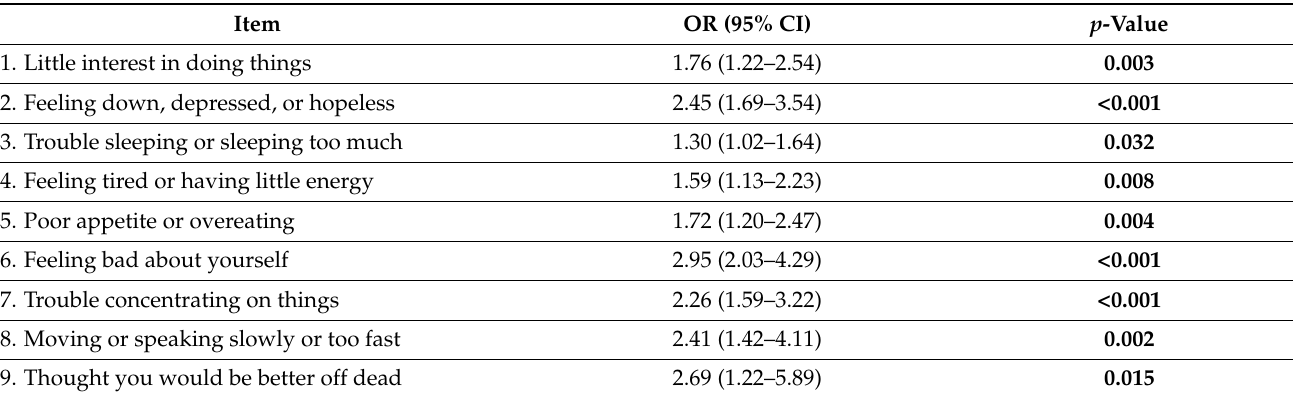
Table 3. Odds ratios of moderately severe to severe depressive symptoms on PHQ-9 items among sexual minorities compared to heterosexuals.